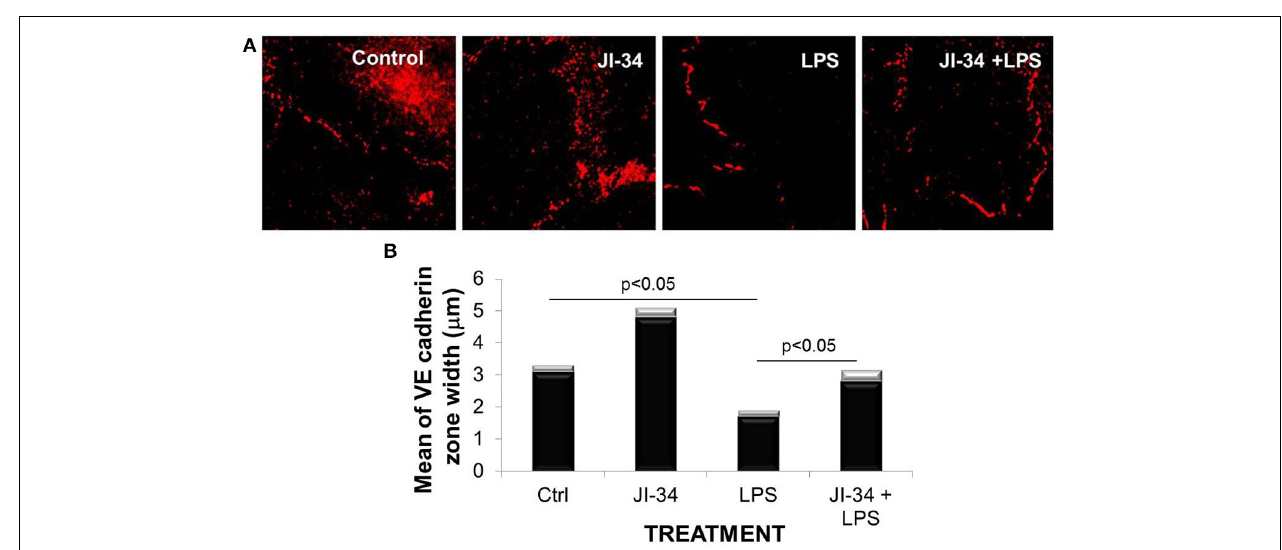
FIGURE 1 | Effect of LPS and JI-34 on VE-cadherin adherens junction of human pulmonary artery endothelial cells (HPAEC). (A) Cells were pretreated with JI-34 (1 μ M, 15min) or not, followed by LPS stimulation (500ng/ml, 6h) and stained with VE-cadherin antibodies for VE-cadherin